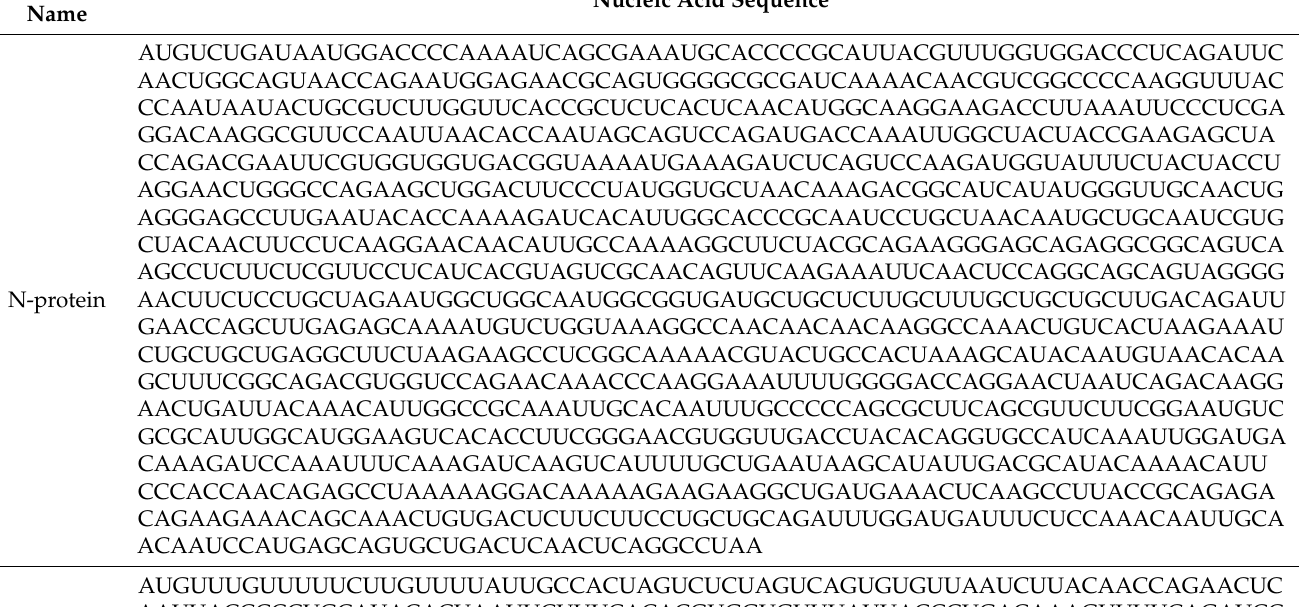
Table 2. Summary of nucleotide sequences for N, S, E, M, ORF1ab, ORF3, ORF6, ORF7, and ORF8 Figure 2. gene were coloured in red. Source: NCBI, Wuhan seafood market pneumonia virus isolate Wuhan-Hu-1, complete